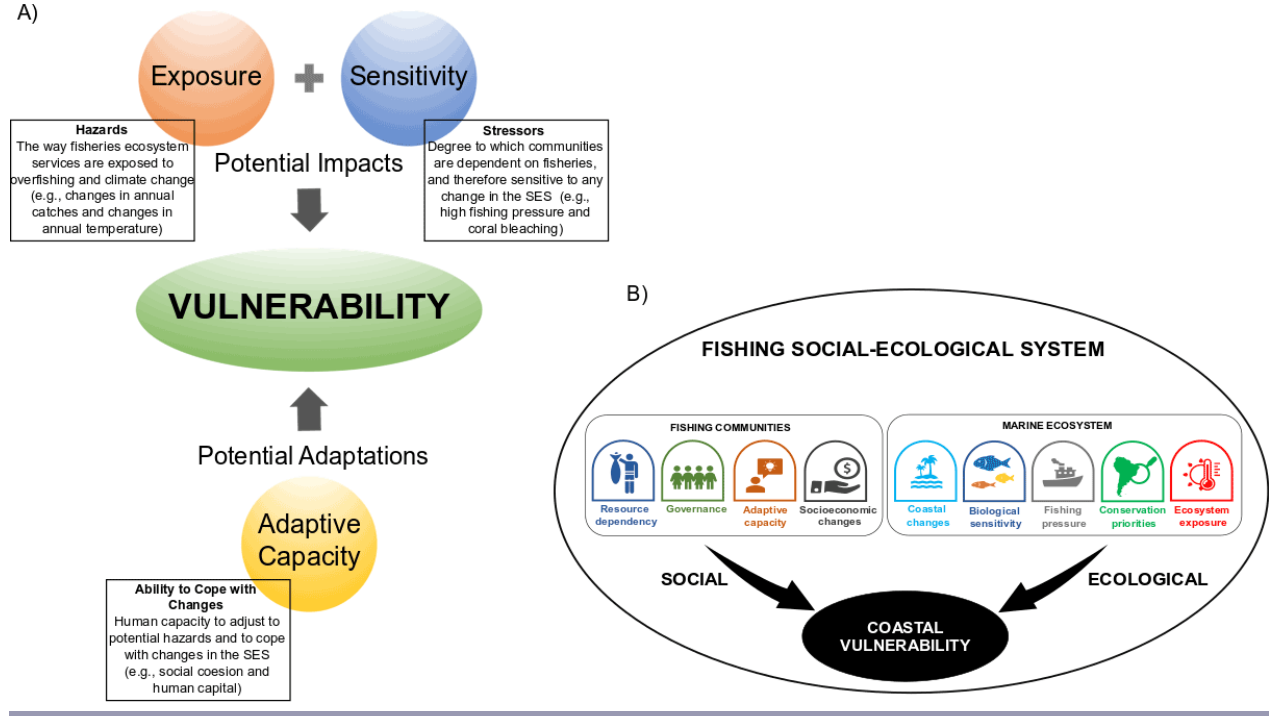
Fig. 1 . (A) Conceptual model of vulnerability (V): the state of susceptibility to harm is the system’s vulnerability, which is determined by exposure (E), sensitivity (S), and adaptive capacity (AC) attributes (Adger 2006), and where V = (E + S) − AC. (B) Conceptual framework of coastal vulnerability nested in the social-ecological fishing system, which presents the interaction between fishing communities and marine ecosystems. Following this framework, variables were created to estimate the system’s susceptibility to be harmed and to capture its vulnerability to social and/or environmental changes at the local/regional scale. SES, social- ecological